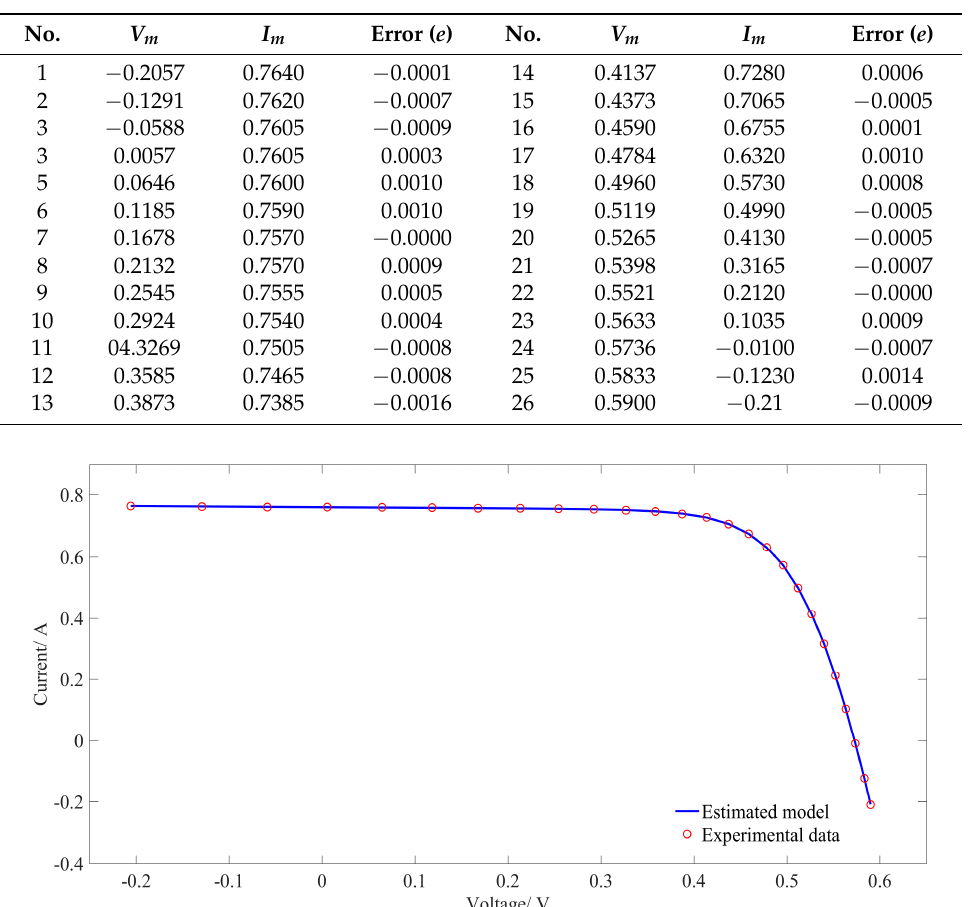
Table 4. Error respective to each measurement for single diode PV model.